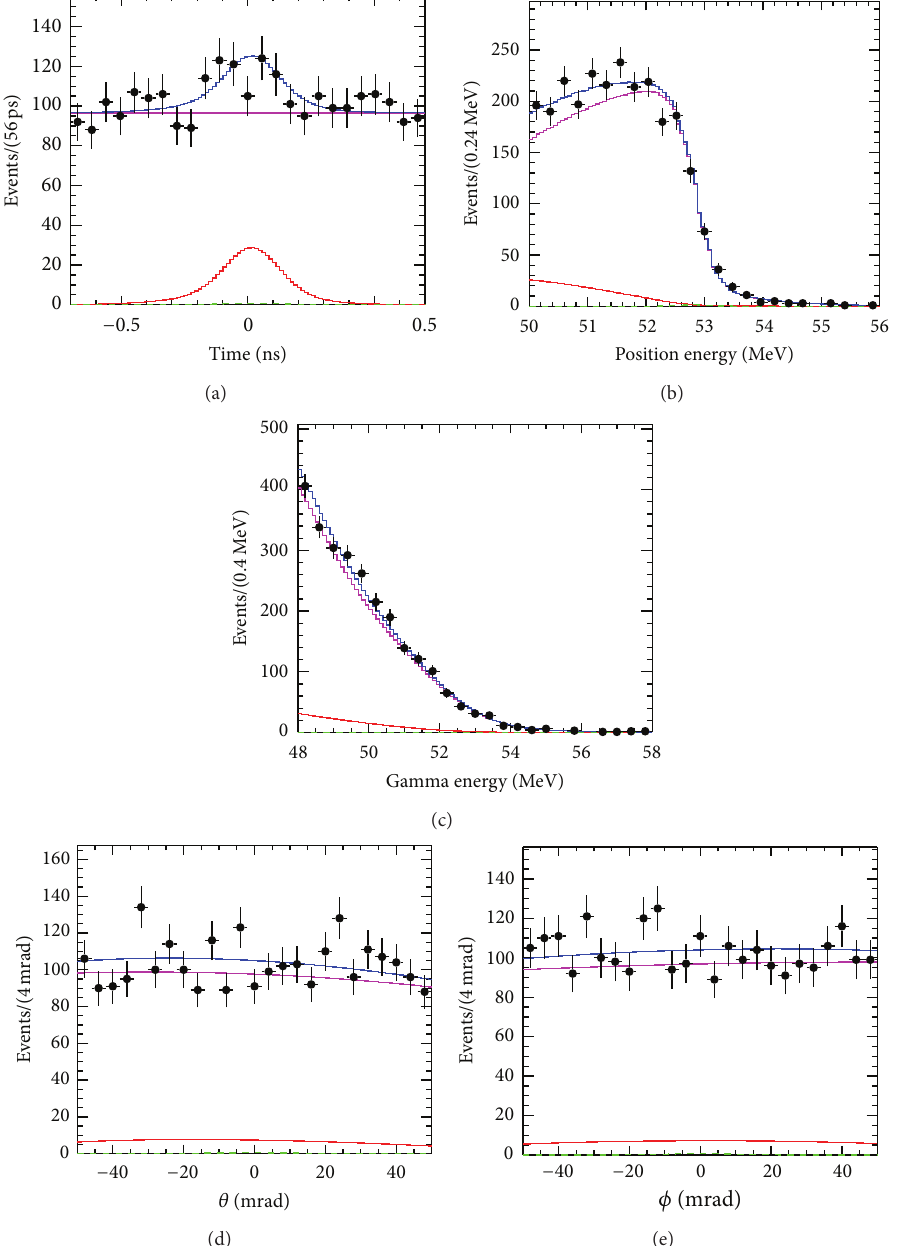
Figure 15: Results of MEG maximum likelihood analysis on full 2009–2011 dataset. From top to bottom, from left to right: Δ𝑇 𝜃 , and 𝜙 . Signal PDFs are in green, RMD PDFs in red, accidental background PDFs in magenta and total PDFs in blue. The black dots e + 𝛾 e + 𝛾 represent the experimental data. The best fit value for the number of signal events is zero within the physical